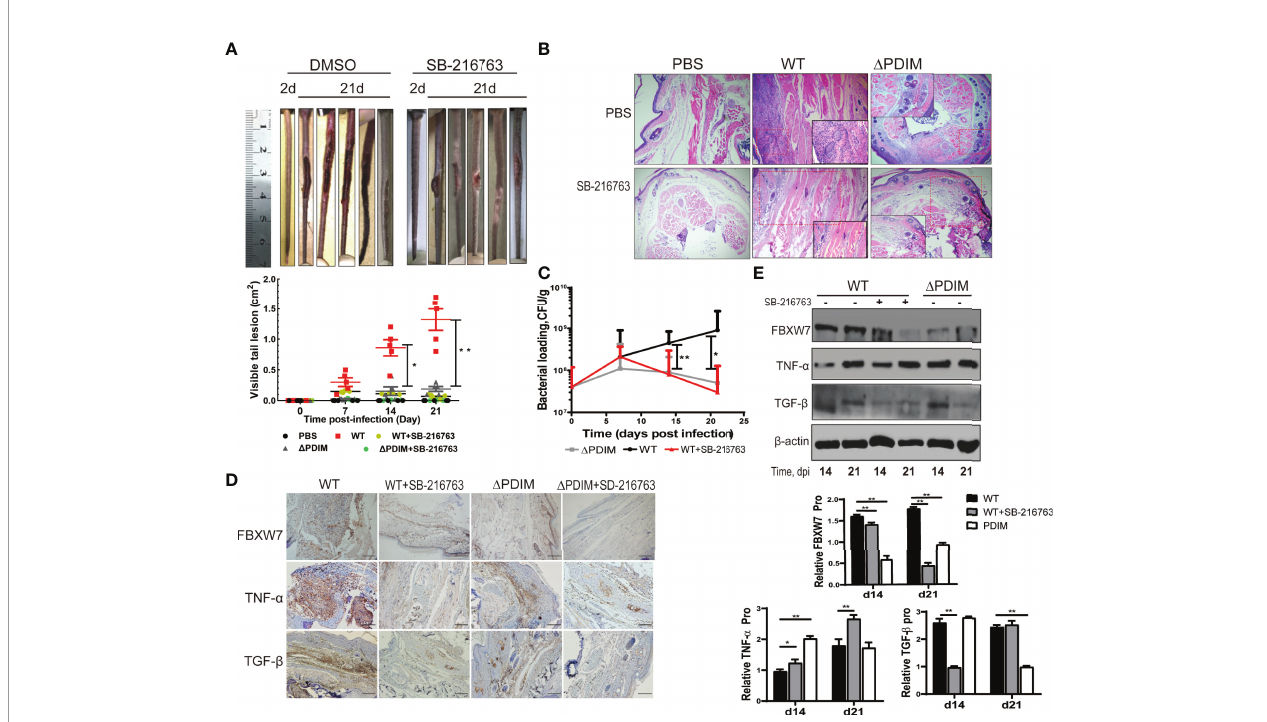
FIGURE 5 | Inhibition of FBXW7 by SB-216763 alleviated tail injury in mice following Mm infection. (A) Tails of WT Mm infected mice treated with vehicle or SB- 216763 for 14 days. The area of all visible lesions on each tail was combined on the 21 st day post-infection and graphed; the bars represent the mean ± standard deviation (SD) (n = 5 per group; 5 groups shown in legend). Signi fi cant differences between the WT and WT+SB-21676 are indicated (* P < 0.05; ** P < 0.01); (B) Representative images of H&E staining of tail lesions. More lymphohistiocytic in fi ltrates were observed in the tail tissues infected with WT Mm compared to the PBS group, while these were somewhat alleviated when the mice were treated with SB-216763. Magni fi cation = 4×. (C) Bacterial burden in the whole tail was quanti fi ed by enumeration of CFU at multiple time points post-infection. The averaged values represent the mean ± standard deviation (SD) (n = 3). (D) Representative immunohistochemical images of FBXW7 staining (brown precipitate) in the tail samples from mice treated as indicated. Nuclei are counterstained with hematoxylin. Scale bar, 500 m m. (E) The expression of TNF- a and TGF- b were detected by Western blot in the tail samples from mice at 14 and 21 days post-infection. b -actin was used as an internal control. * P < 0.05 and ** P <